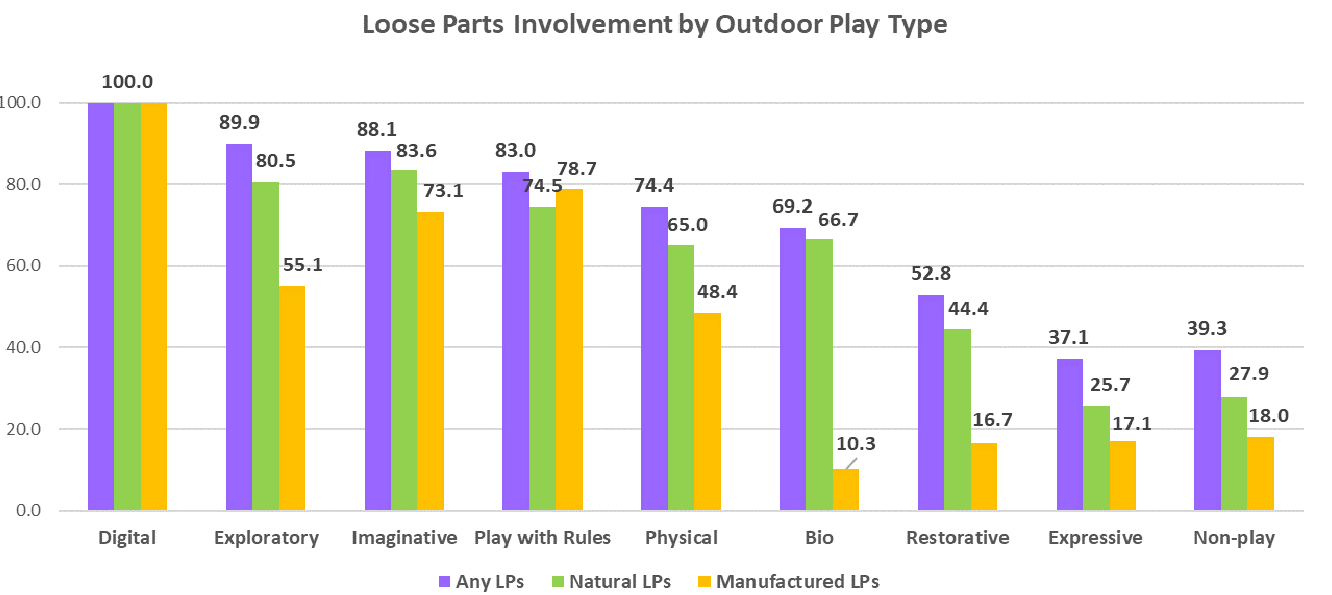
Figure 11. Loose parts’ involvement in outdoor play types.